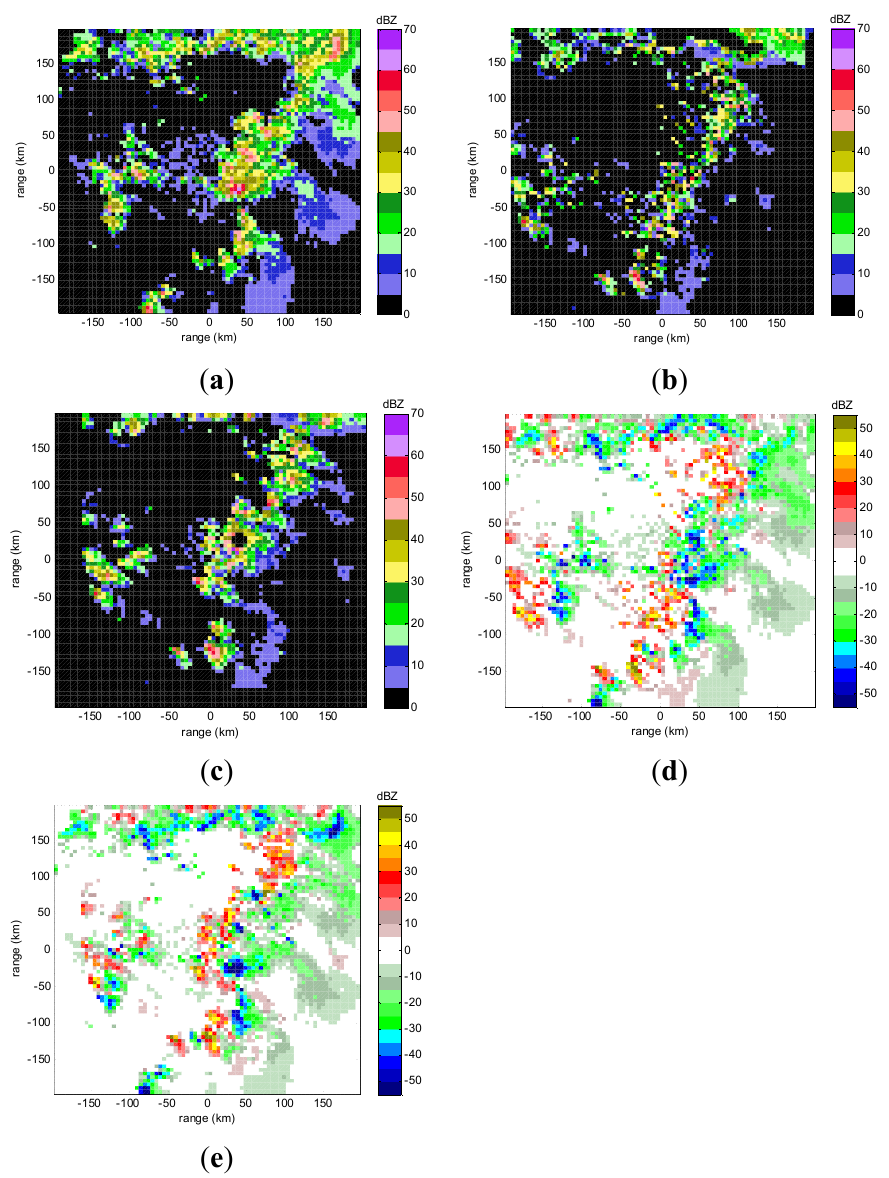
Figure 4. Radar reflectivity at 3 km height of the Changsha case at 13:26 (UTC) on 11 April 2006 with radar station at origin (0,0). ( a ) actual reflectivity; ( b ) forecasting reflectivity by COTREC; ( c ) forecasting reflectivity by GVAD; ( d ) difference between forecasting reflectivity by COTREC and actual reflectivity; ( e ) difference between forecasting reflectivity by GVAD and actual